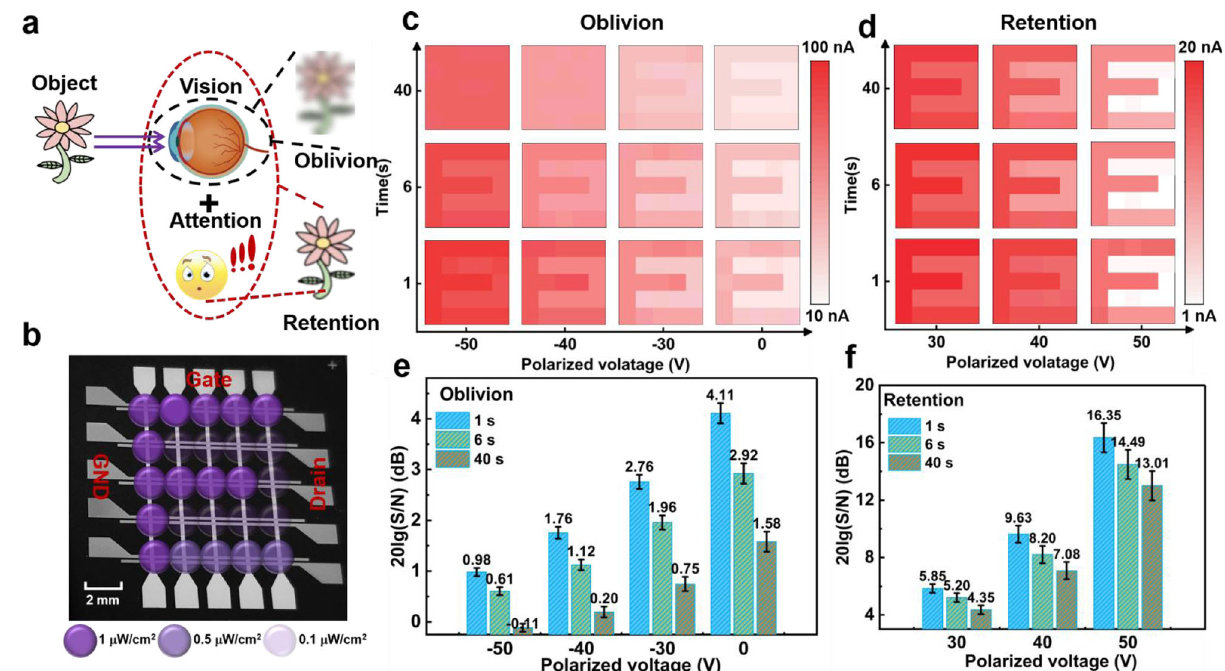
Fig. 4 | The arti fi cial visual perception arrays to detect UV light information. a The schematic diagram of the object recognized by the visual system with the attention and without attention. b Optical microscopy image of the arti fi cial visual perception including 5×5 pixel arrays. c The encoded images (output current)